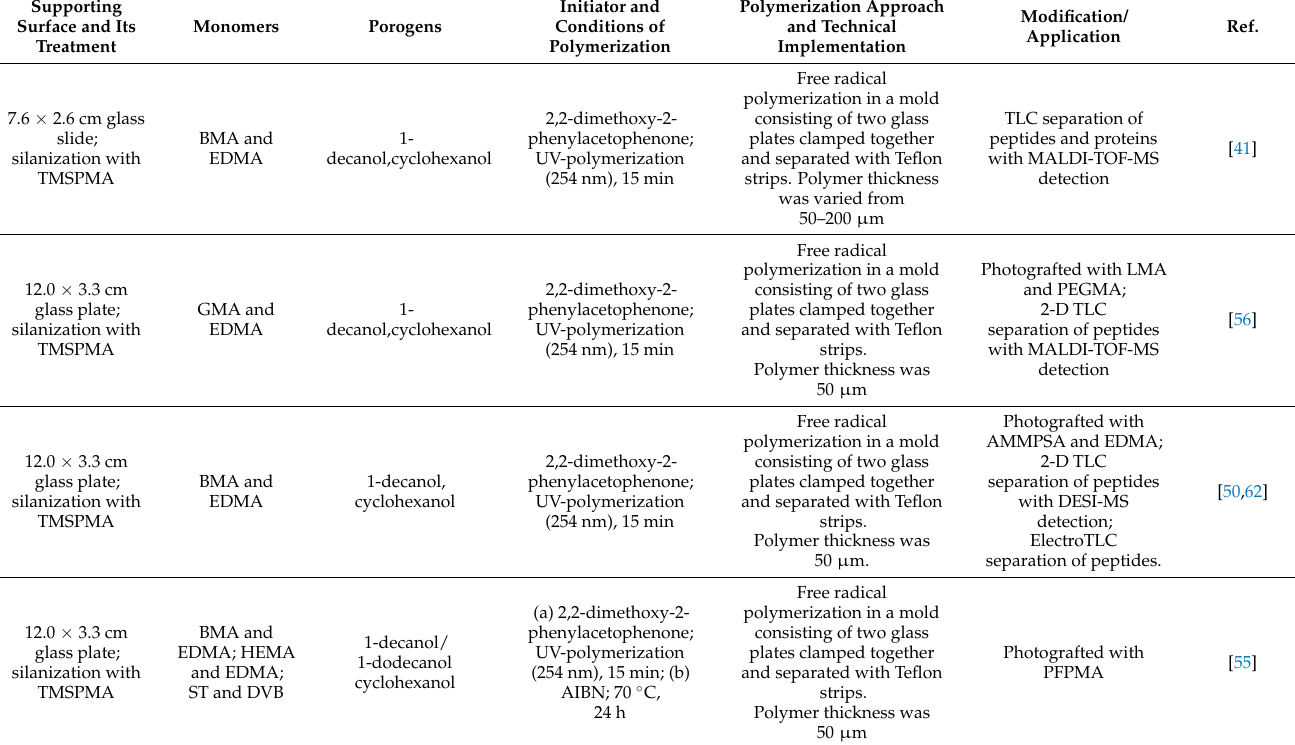
Table 1. Summary on preparation and application of macroporous monolithic polymer layers.